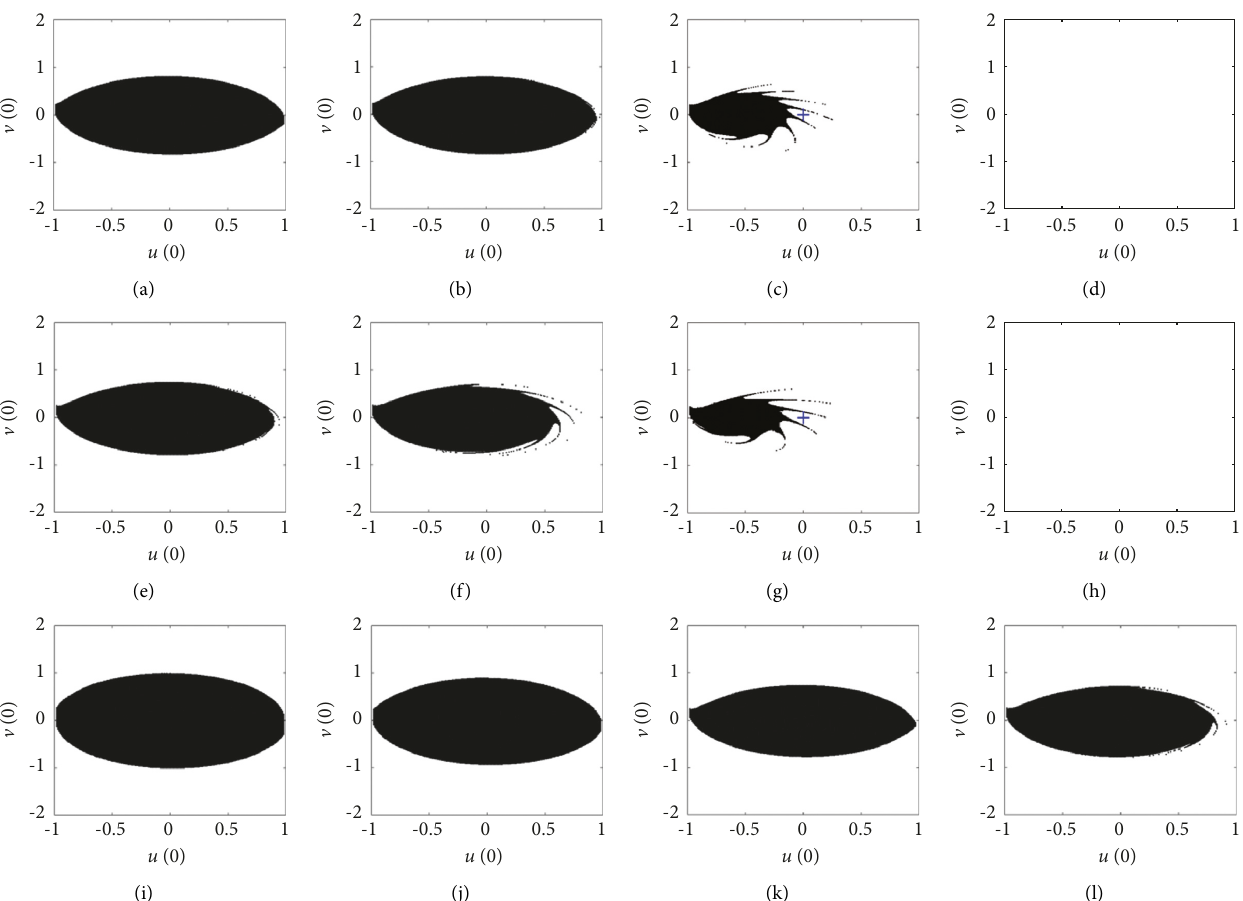
Figure 11: Evolution of safe basins of system (2) with the variation of α and f � 0 . 4. (d) α � 0 . 1, f α � 0 . 1, f 0 � 0 . 24. (j) α � 0 . 28, f f 0